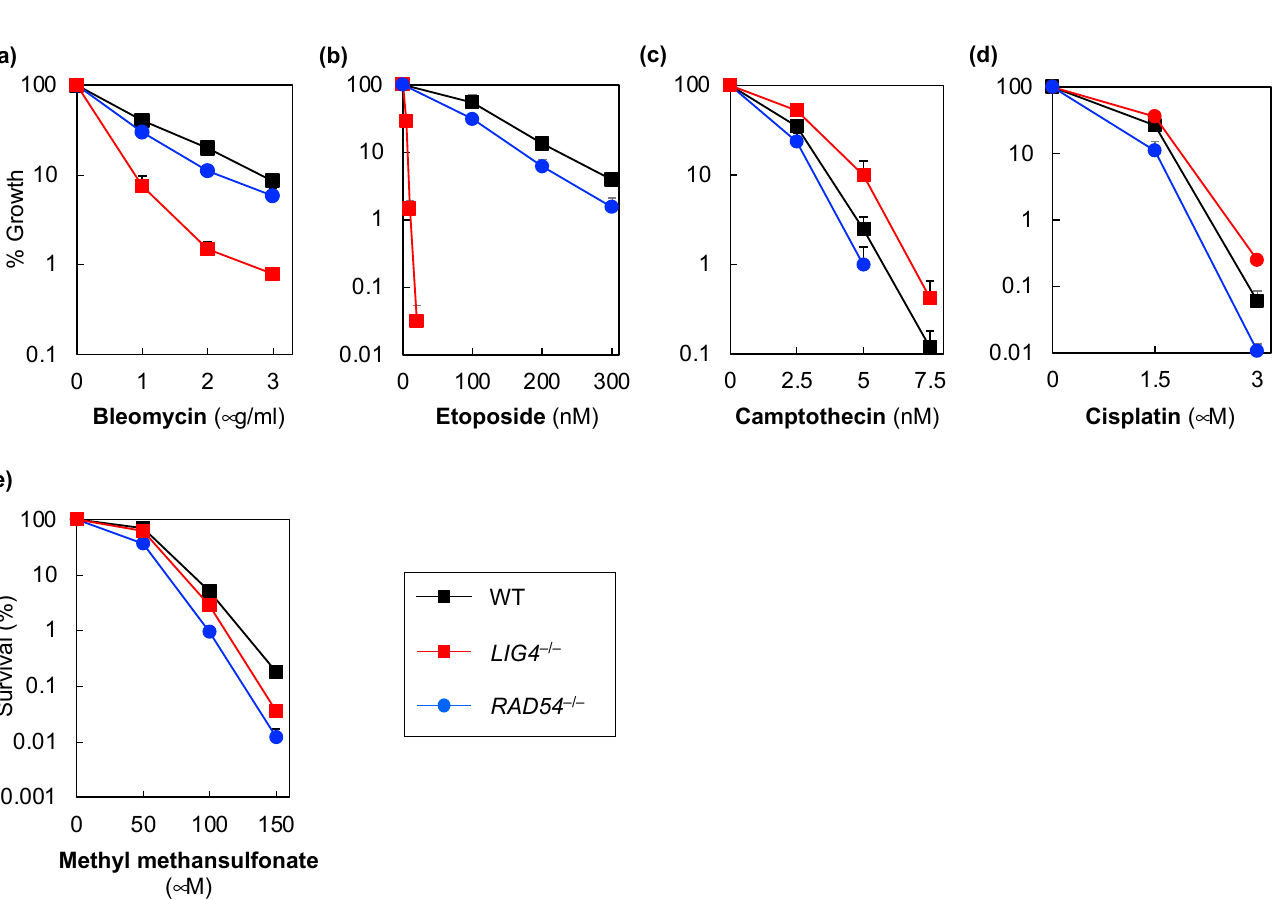
Table 1. Summary of the DSB types caused by DNA damage inducers analyzed using Nalm-6 cells. DNA Damage In-